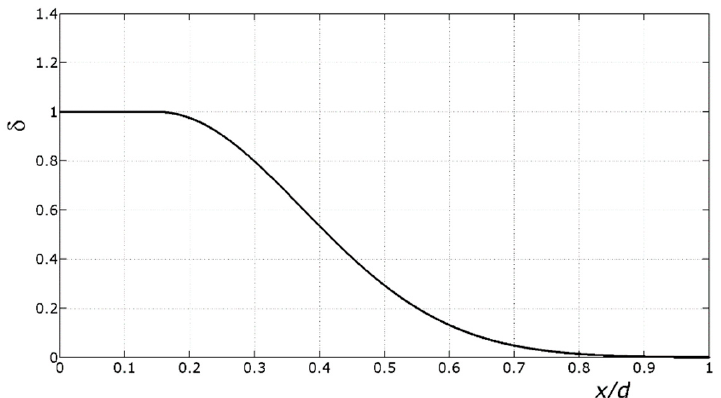
Figure 5. Graphic of Equation (16), which relates the coefficient δ to the ratio of the neutral axis depth to effective depth y / d of the first plastic hinge that forms. The coefficient δ reduces the bending moment of the last plastic hinge(s).